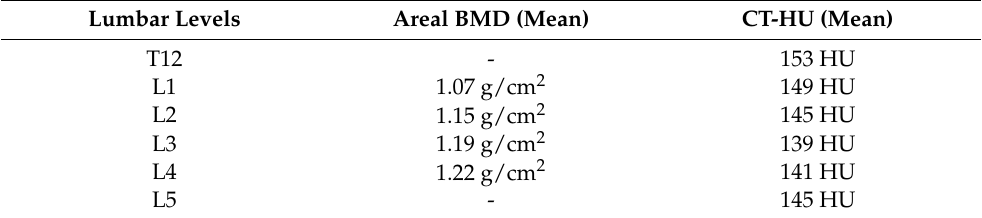
Table A1. Mean Areal BMD and mean CT-HU for each vertebral level.